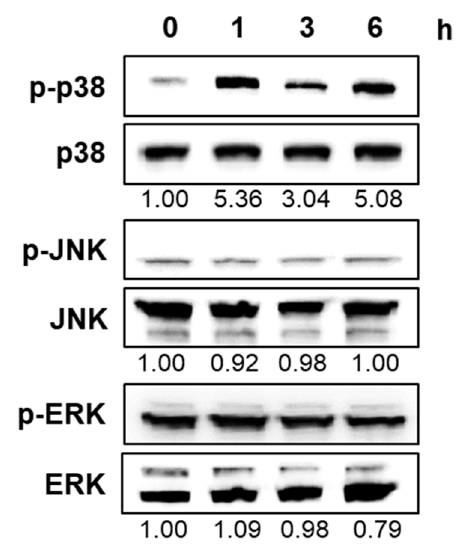
Figure 4. Effect of CT on mitogen-activated protein kinase (MAPK) activation. Western blot using HL-60 cells subjected to CT treatment (10 μ M) for different durations to assess MAPKs and their phosphorylated forms, including phospho-p38 (p-p38), p38, phospho- c-Jun N-terminal kinase (JNK) (p-JNK), JNK, phospho- extracellular signal-regulated kinase (ERK) (p-ERK), and ERK. The relative band intensity of the phosphorylated form to the total protein is expressed as the fold change compared to the control (0 h) and is indicated below each band.